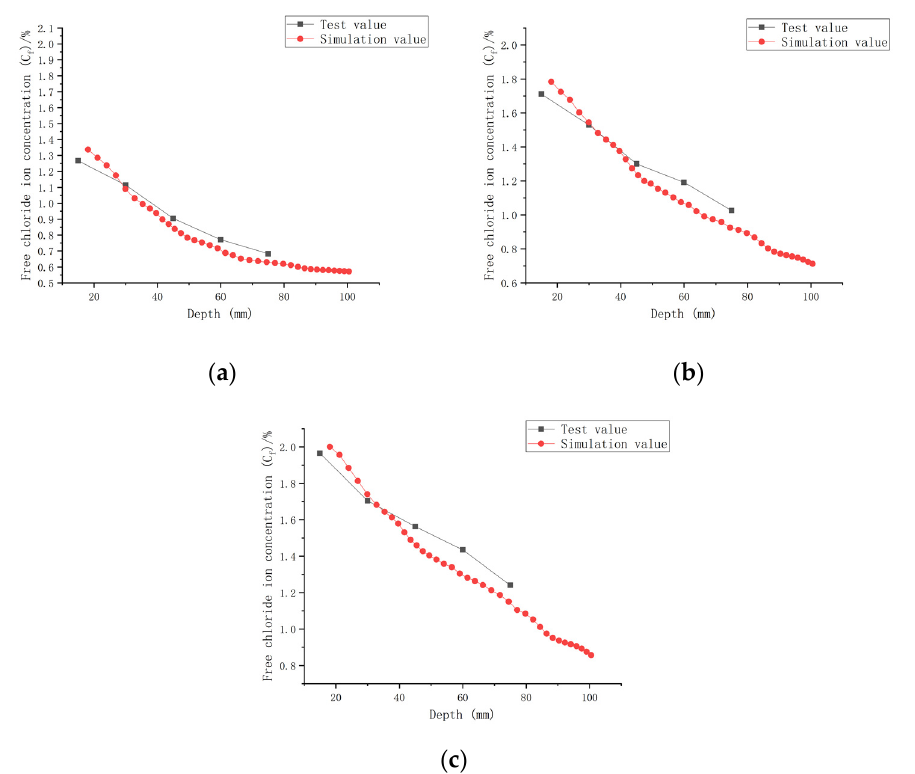
Figure 15. Relationship between C f and depth (W/C = 0.40). ( a ) Load is 0; ( b ) load is 0.1; ( c ) load is